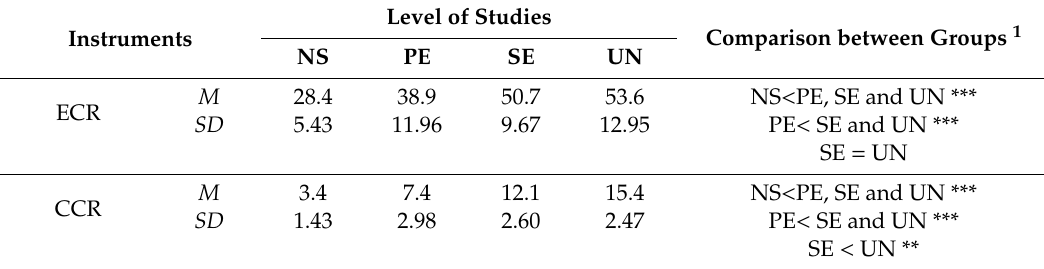
Table 6. ANOVA and descriptive statistics on deterioration cognitive reserve.